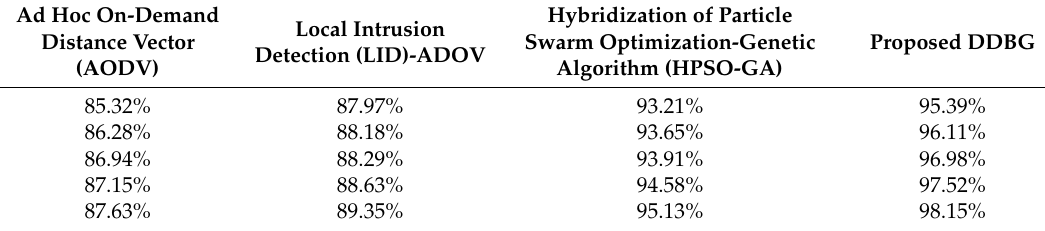
Table 4. The detection rate evaluation